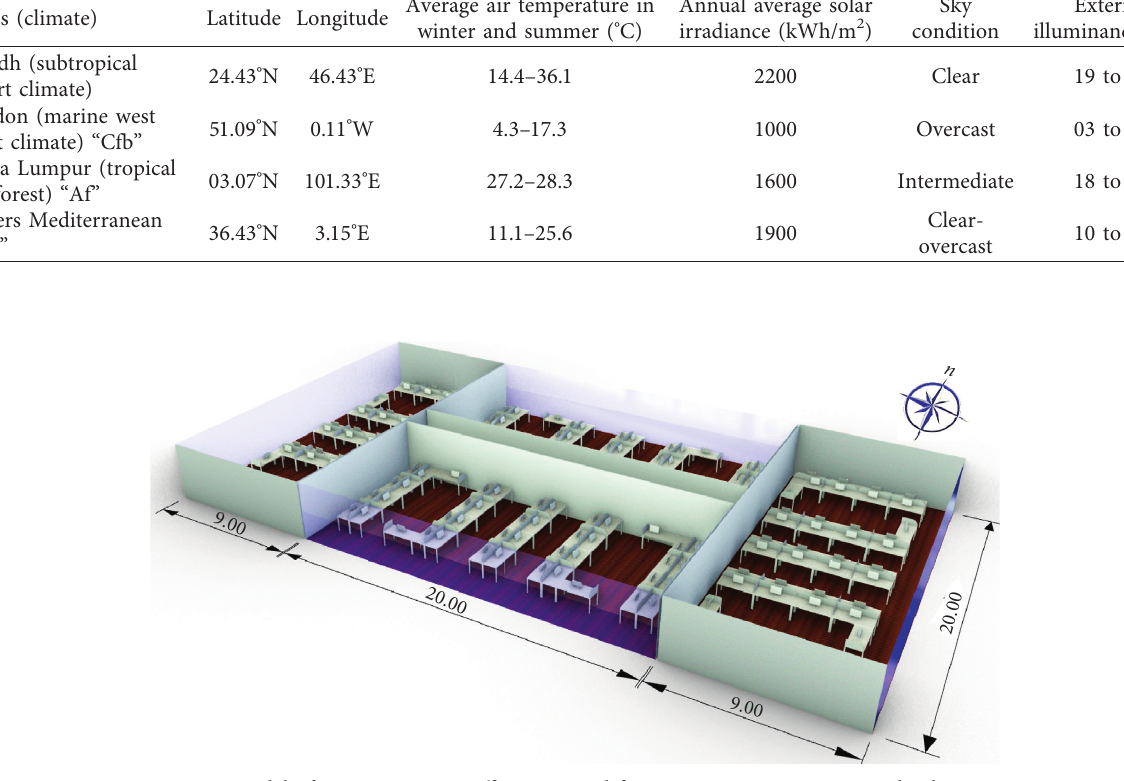
Figure 1: 3D model of perimeter open-office zone and furniture arrangements in cardinal orientation.